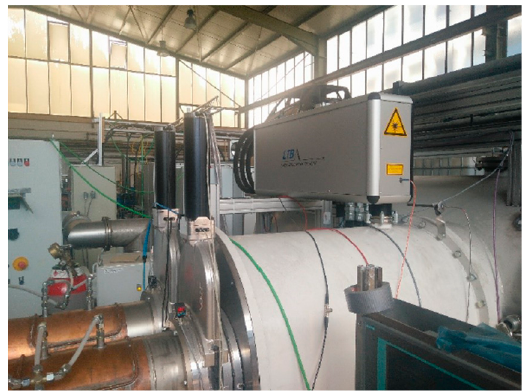
Figure 9. LIBS- system installed at plasma coating device.